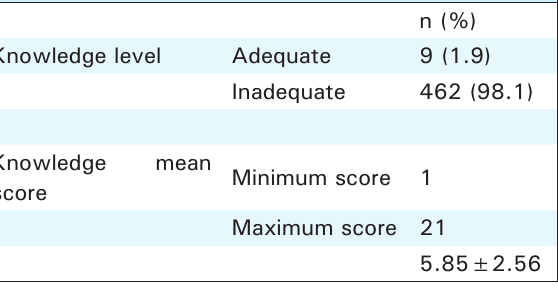
Table 4. Knowledge level of